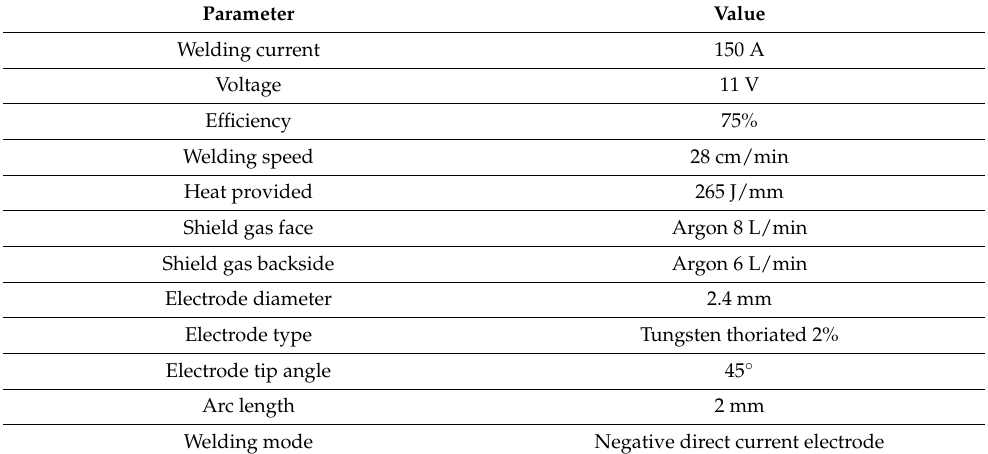
Table 3. Welding